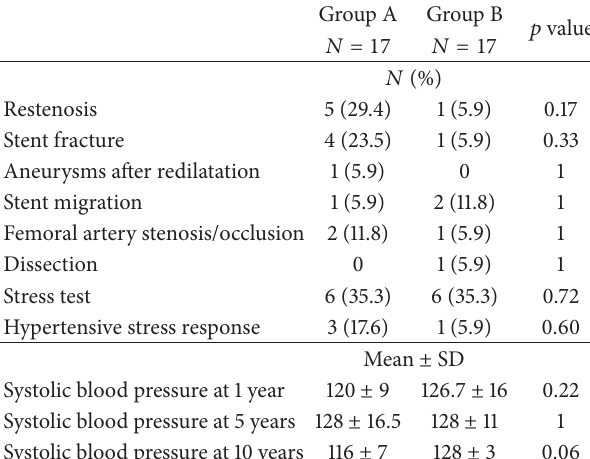
Table 2: Late adverse events and follow-up data.